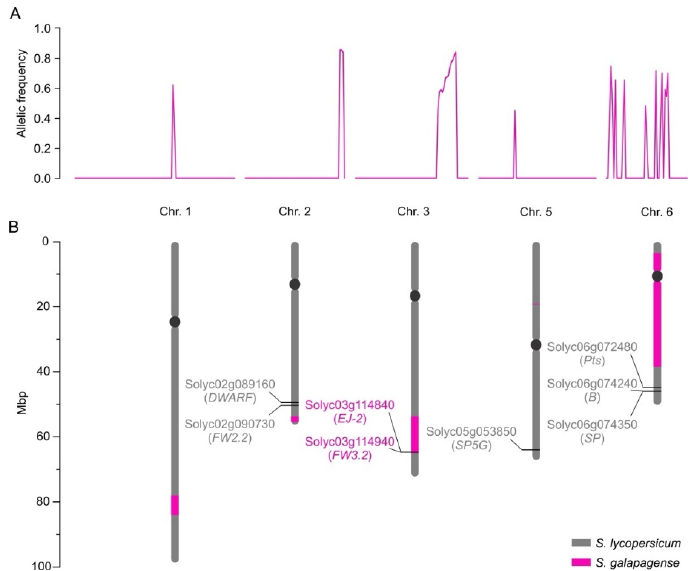
Figure 5. Mapping-by-sequencing results. ( A ) Allelic frequency indicates the chromosomal positions where MT- Get has introgressions from S. galapagense LA1401. ( B ) Representation of the corresponding positions of the chromosomal fragments from S. galapagense (pink bars) introgressed into MT- Get . The positions were based on the S. lycopersicum cv. Heinz reference genome sequence. Relevant genes (as discussed in the text) and their SGN (Solyc) ID numbers are represented. Note that the MT- Get genome bears the MT-mutated alleles for DWARF [37] and SP [38], which are determinants of the MT reduced plant size and determinate growth habit, respectively [39]. The presence of the MT allele at the SP5G locus also contributes to the reduced plant size of MT- Get , since the S. galapagense allele promotes additional vegetative growth due to a lack of flower induction under long days [40]. MT- Get also lacks S. galapagense alleles for genes conferring additional phenotypes distinct to this wild species, such as highly dissected leaves ( Pts ) [41], and β -carotene accumulating fruits ( B ) [42]. Figure S6 depicts and discusses the effect of the wild species alleles EJ-2 and FW3.2 on the MT- Get